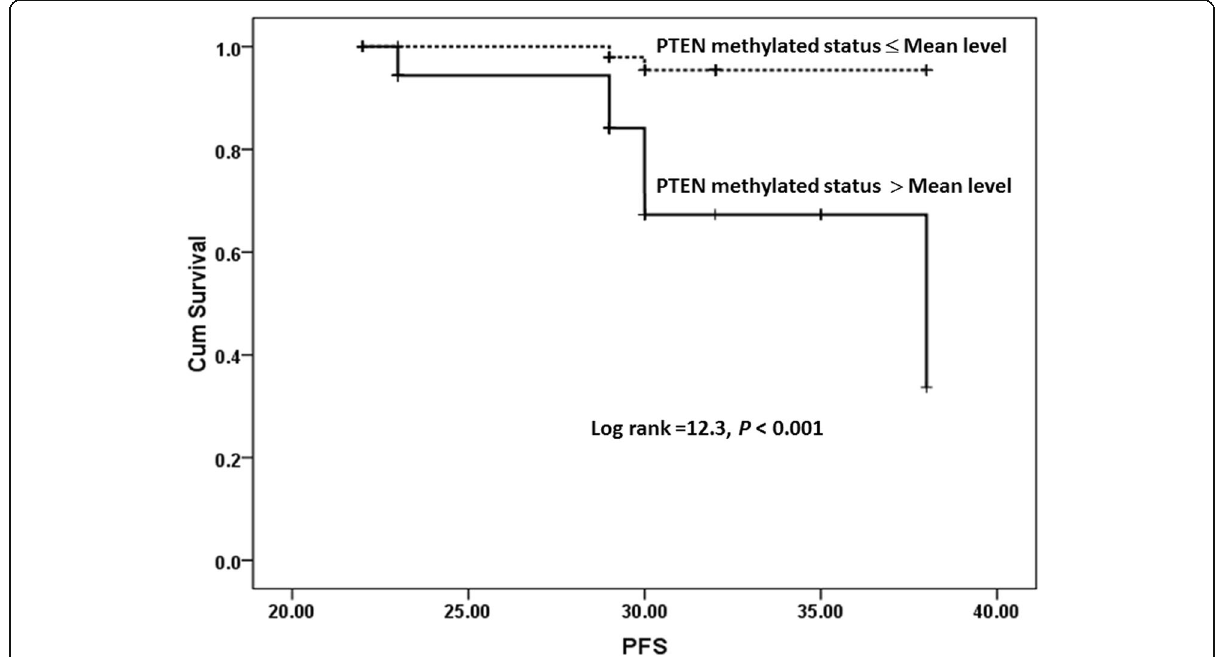
Fig. 3 Progression-free survival of BC patients for PTEN